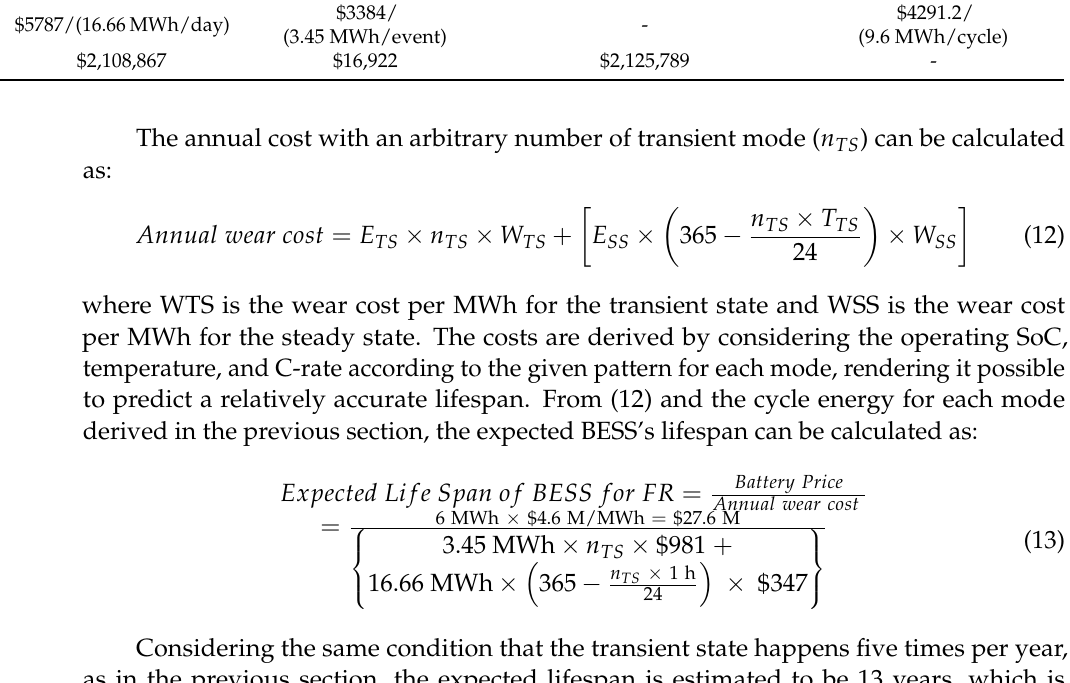
Table 1. Wear cost calculated using WDF (24 MW/6 MWh BESS is considered with n TS = 5). Transient State Combined Cycle Manufacture Specific Steady-State (0.2C) (4C Discharge and 0.2C (Steady-State + Transient State) 80% DoD Cycle Recovering Charge)